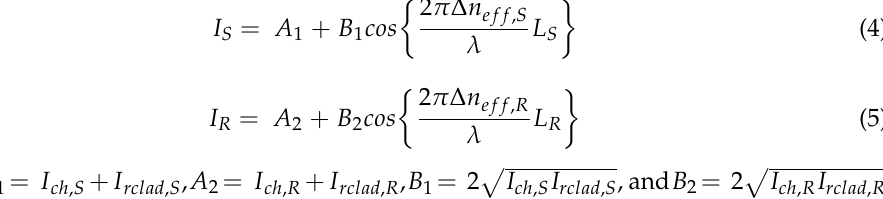
Figure 6. Schematic drawing of two cascaded MZI with different lengths.